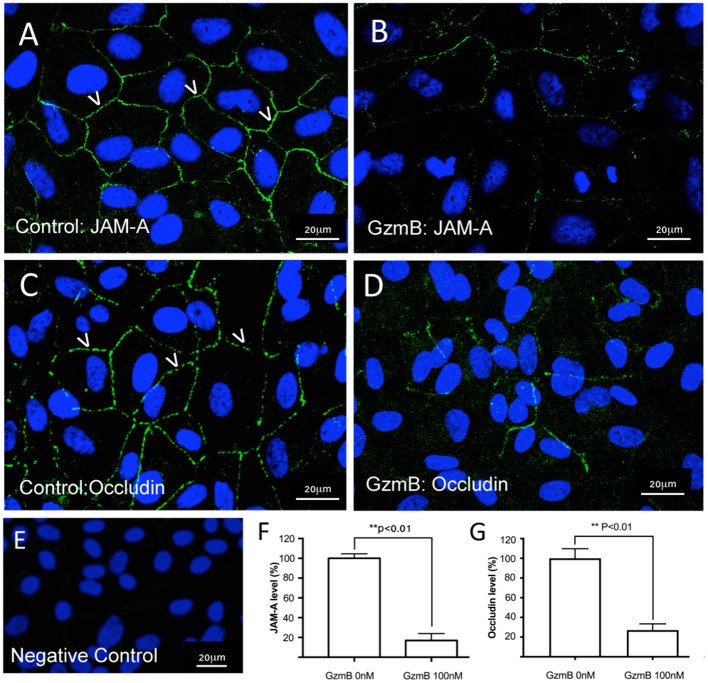
Reduced immunoreactivity of JAM-A and Occludin in ARPE-19 cells stimulated by exogenous GzmB. (A) JAM-A immunoreactivity demonstrates tight junctional contacts (green 488 nm, some shown by white arrowheads) on RPE in controls wells (GzmB = 0 nM). (B) After 6 h with GzmB stimulation (100 nM), JAM-A immunoreactivity is reduced on ARPE-19. (C) Occludin immunoreactivity between cells (some shown by white arrowheads) in control wells (GzmB = 0 nM). (D) After 6 h with GzmB stimulation (100 nM), Occludin immunoreactivity is reduced on ARPE-19. (E) Omission of primary antibody demonstrates no immunoreactivity. Significant differences were observed for (F) JAM–A and (G) Occludin using an independent-sample T-Test (N = 6 per group) between control and GzmB-treated group: mean ± SEM; **p < 0.01. Images were taken from ARPE-19 cells and are representative of primary RPE experiments undertaken at the same time. DAPI (405 nm) labeling of nuclei is shown in blue. Scale bar = 20 μm.